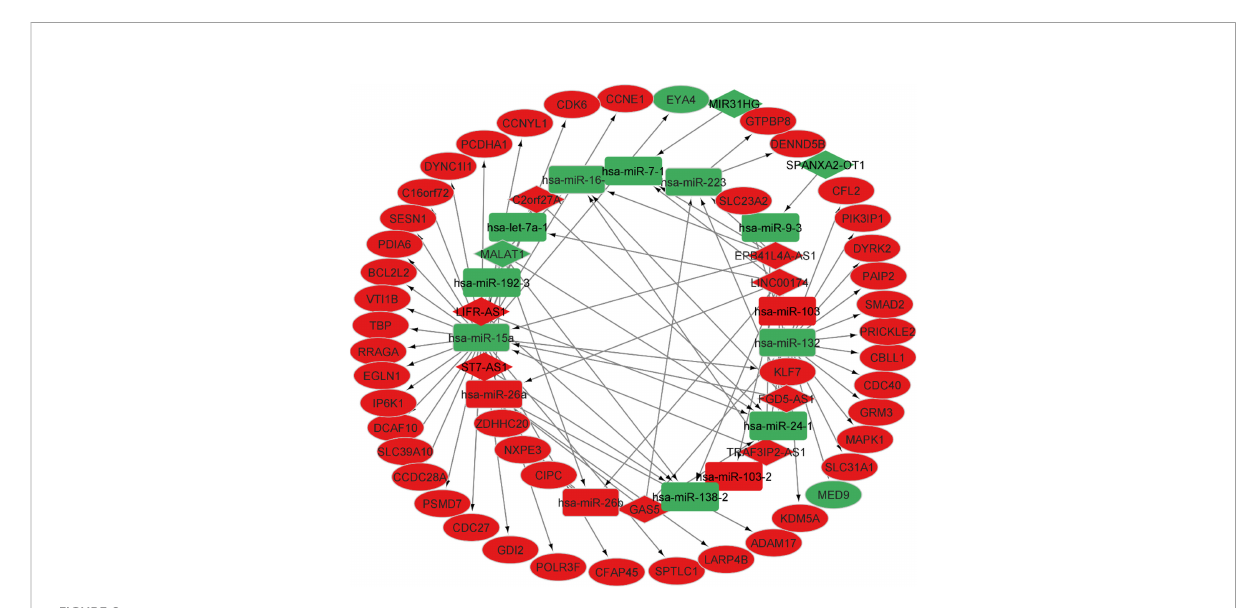
FIGURE 8 CeRNA network in NFPA. Red nodes show a high level of expression, while green nodes show a low level of expression. Ellipses represent protein-coding genes; round rectangles represent miRNAs; diamonds show lncRNAs; gray edges indicate lncRNA-miRNA-mRNA interactions.